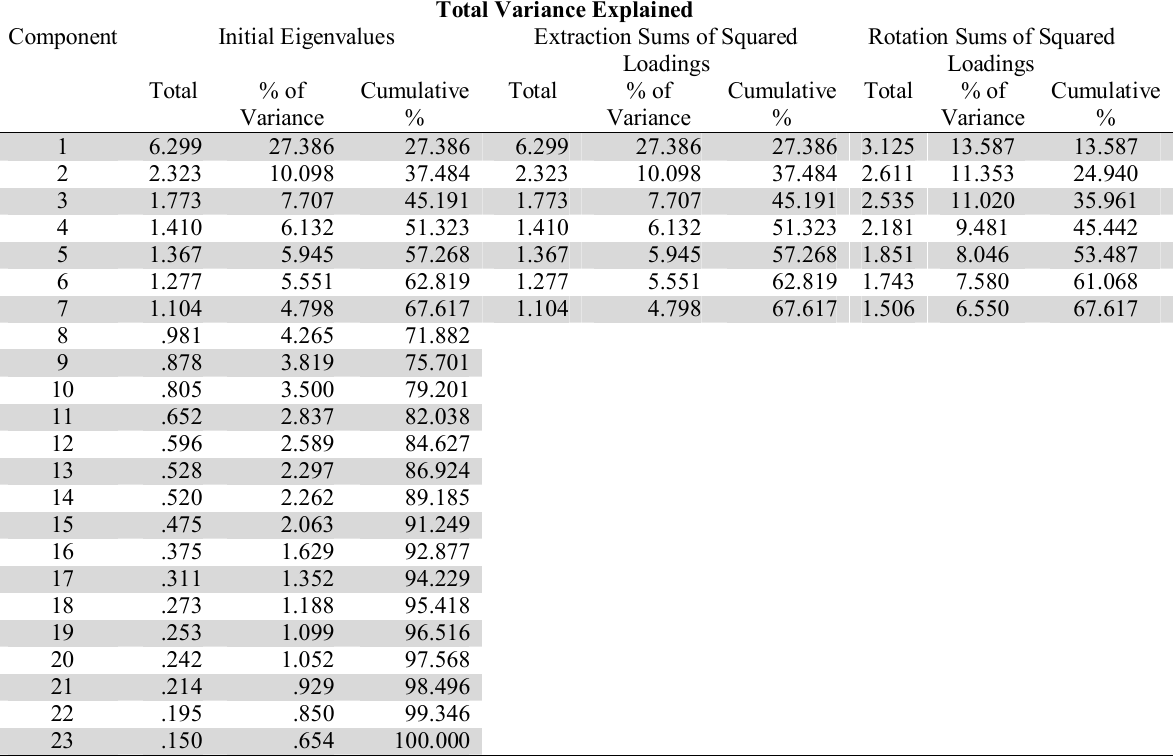
The results of total variance explained